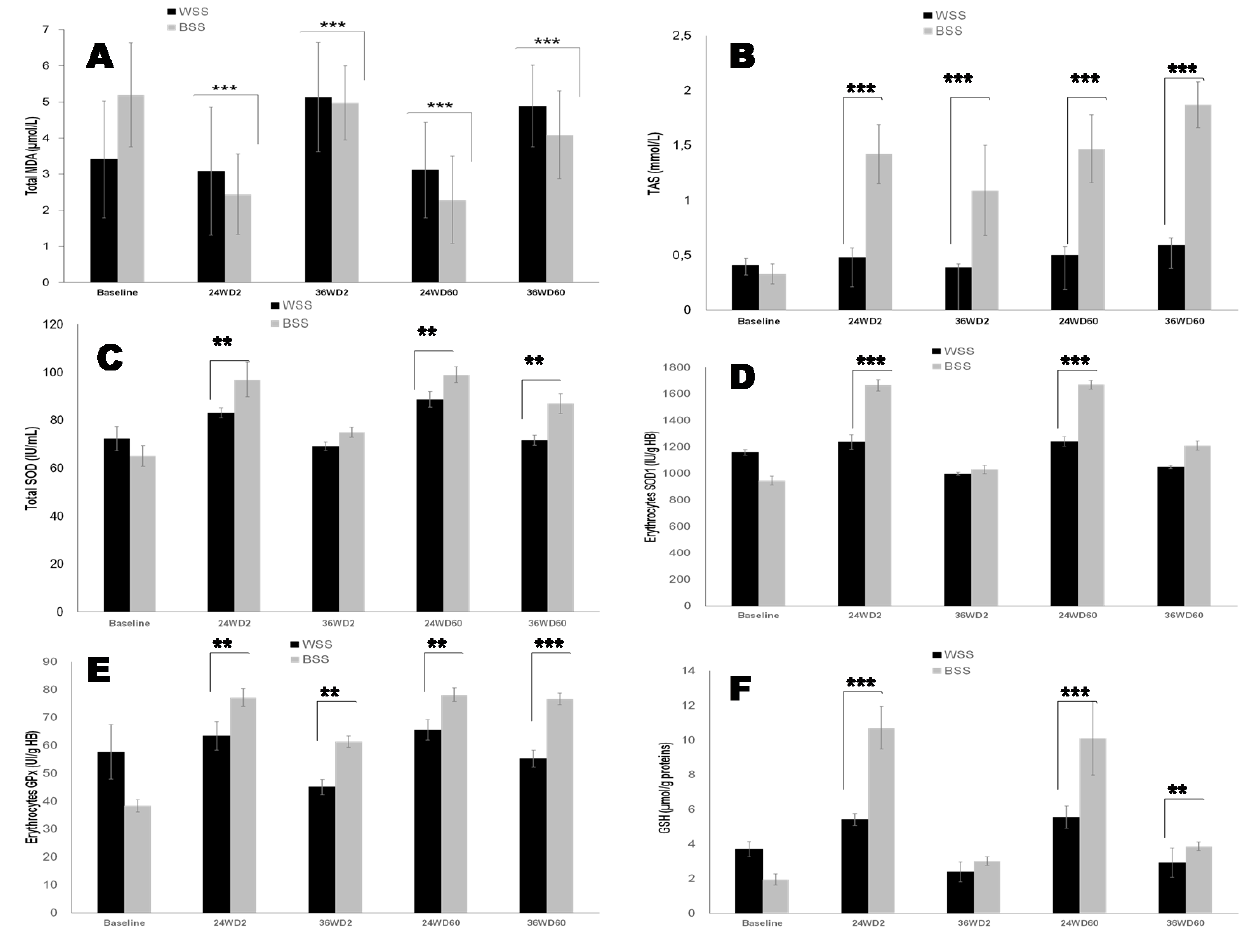
Figure 4. Effects of oral 2000 IU/day and 60,000 IU/month vitamin D 3 supplementation on serum oxidative stress biomarkers in Black versus White SS CKD participants. ( A ): Blood total MDA (Mal- ondialdehyde); ( B ): Blood TAS (Total Antioxidant Status); ( C ): Total SOD (total Superoxide dismutase activity); ( D ): Erythrocytes SOD 1; ( E ): Erythrocytes GPx (Glutathione peroxidase); ( F ): serum GSH (glutathione). The mean values are assigned from the standard error to the mean (X ± ESM). The degree of significance is calculated for a risk of error α = 5%. The mean comparison is established for each group, White SS and Black SS. Baseline data were obtained before vitamin D supplementation. p -value is calculated at baseline time (White SS versus Black SS groups). ** p < 0.01; *** p <